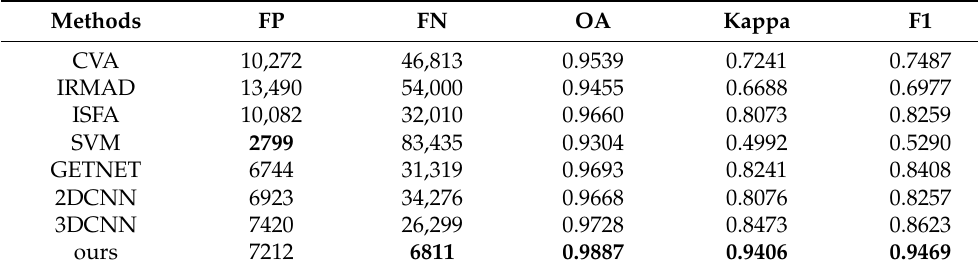
Figure 6. The change map on Bastrop dataset. ( a ) CVA. ( b ) IRMAD. ( c ) ISFA. ( d ) SVM. ( e ) GETNET. ( f ) 2DCNN. ( g ) 3DCNN. ( h ) ours. Table 1. Quantitative evaluation of CD results by different methods for Bastrop